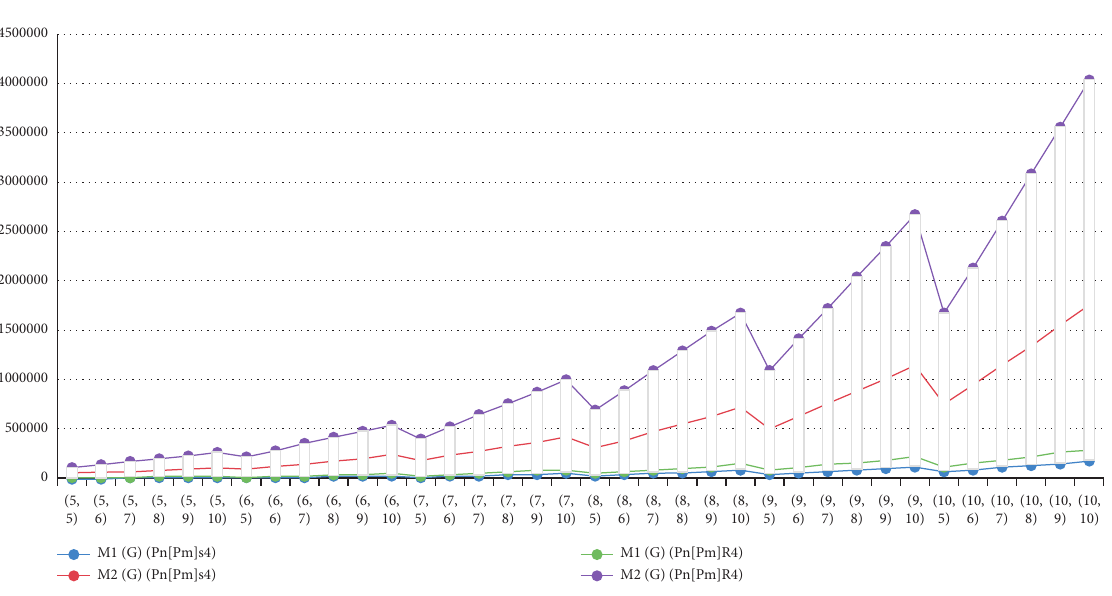
Figure 8: Numerical comparison of Zagreb indices of generalized subdivision and semitotal point operations with lexicographic product of the networks for k �